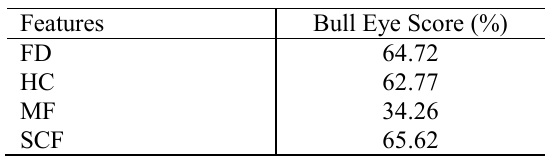
Figure 12. Image4 retievals using Histogram Of Oriented Gradients